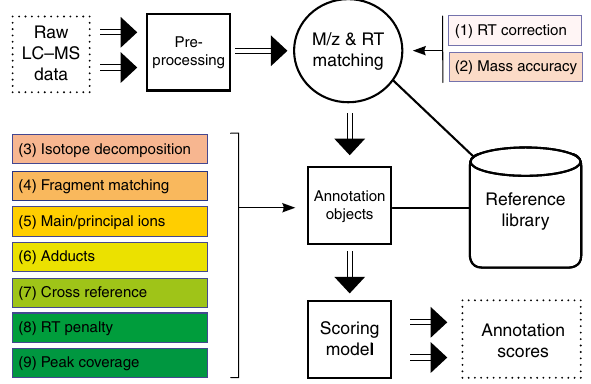
Figure 2 | The MatchWeiz software annotation workflow. Raw LC–MS data are preprocessed to produce peak tables. Next, the input data are concatenated through a preliminary m / z and RT matching function, getting inputs from modules (1) and (2), which relates peak groups from the input data to library entries. Modules (3)–(9) then process particular aspects of the data and return their results to an annotation object containing the obtained information regarding putative hits. Information is finally evaluated by the scoring model, which gives each annotation a score based on all available